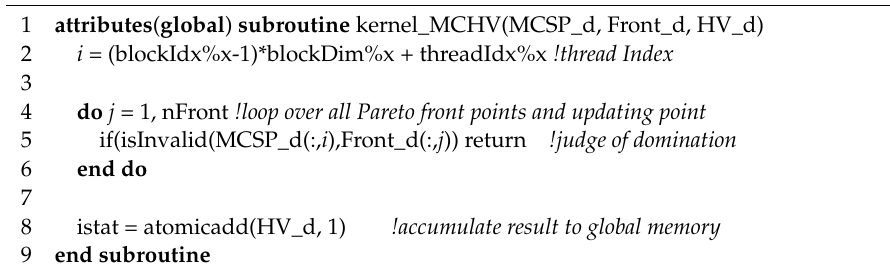
Algorithm 2. Code snippet of the kernel for GPU-based MCHVI